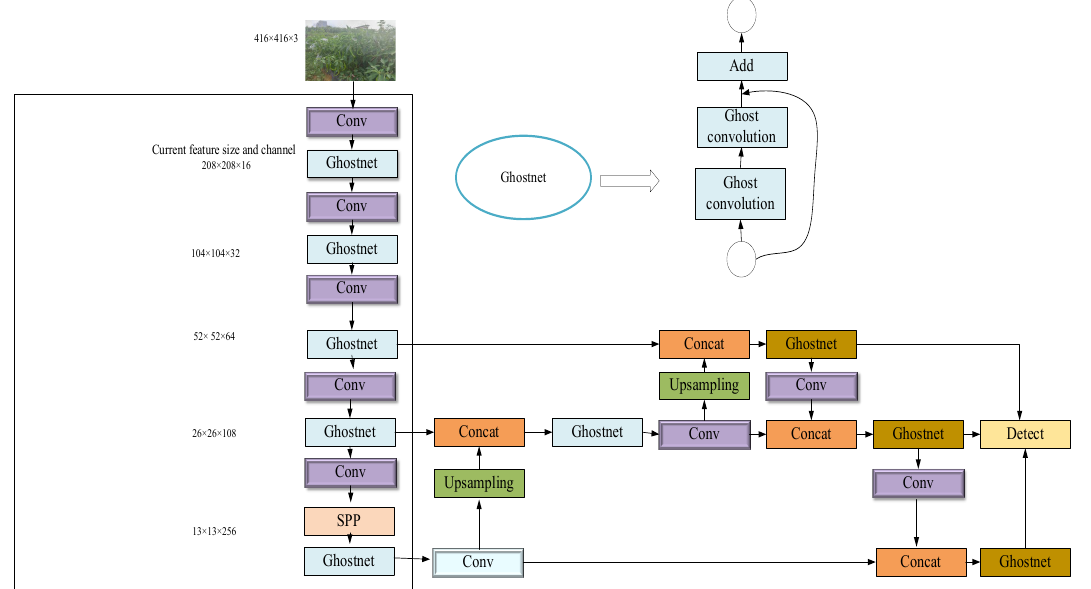
Figure 1. GN - YOLOv5s network architecture. Figure 1. GN-YOLOv5s network